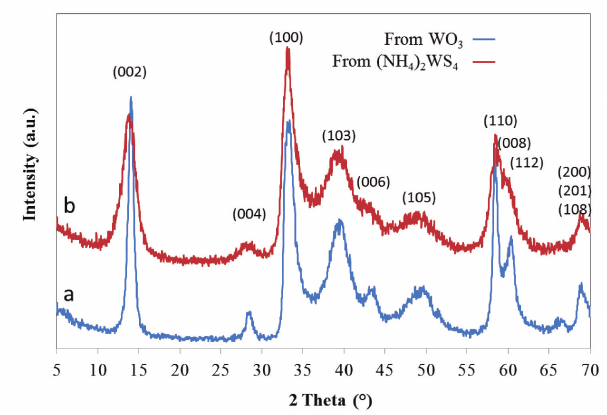
Figure 1. XRD patterns of IF-WS IF-WS generated from ( a ) commercial WO 2 tetrathiotungstate. All peaks were identified as IF-WS